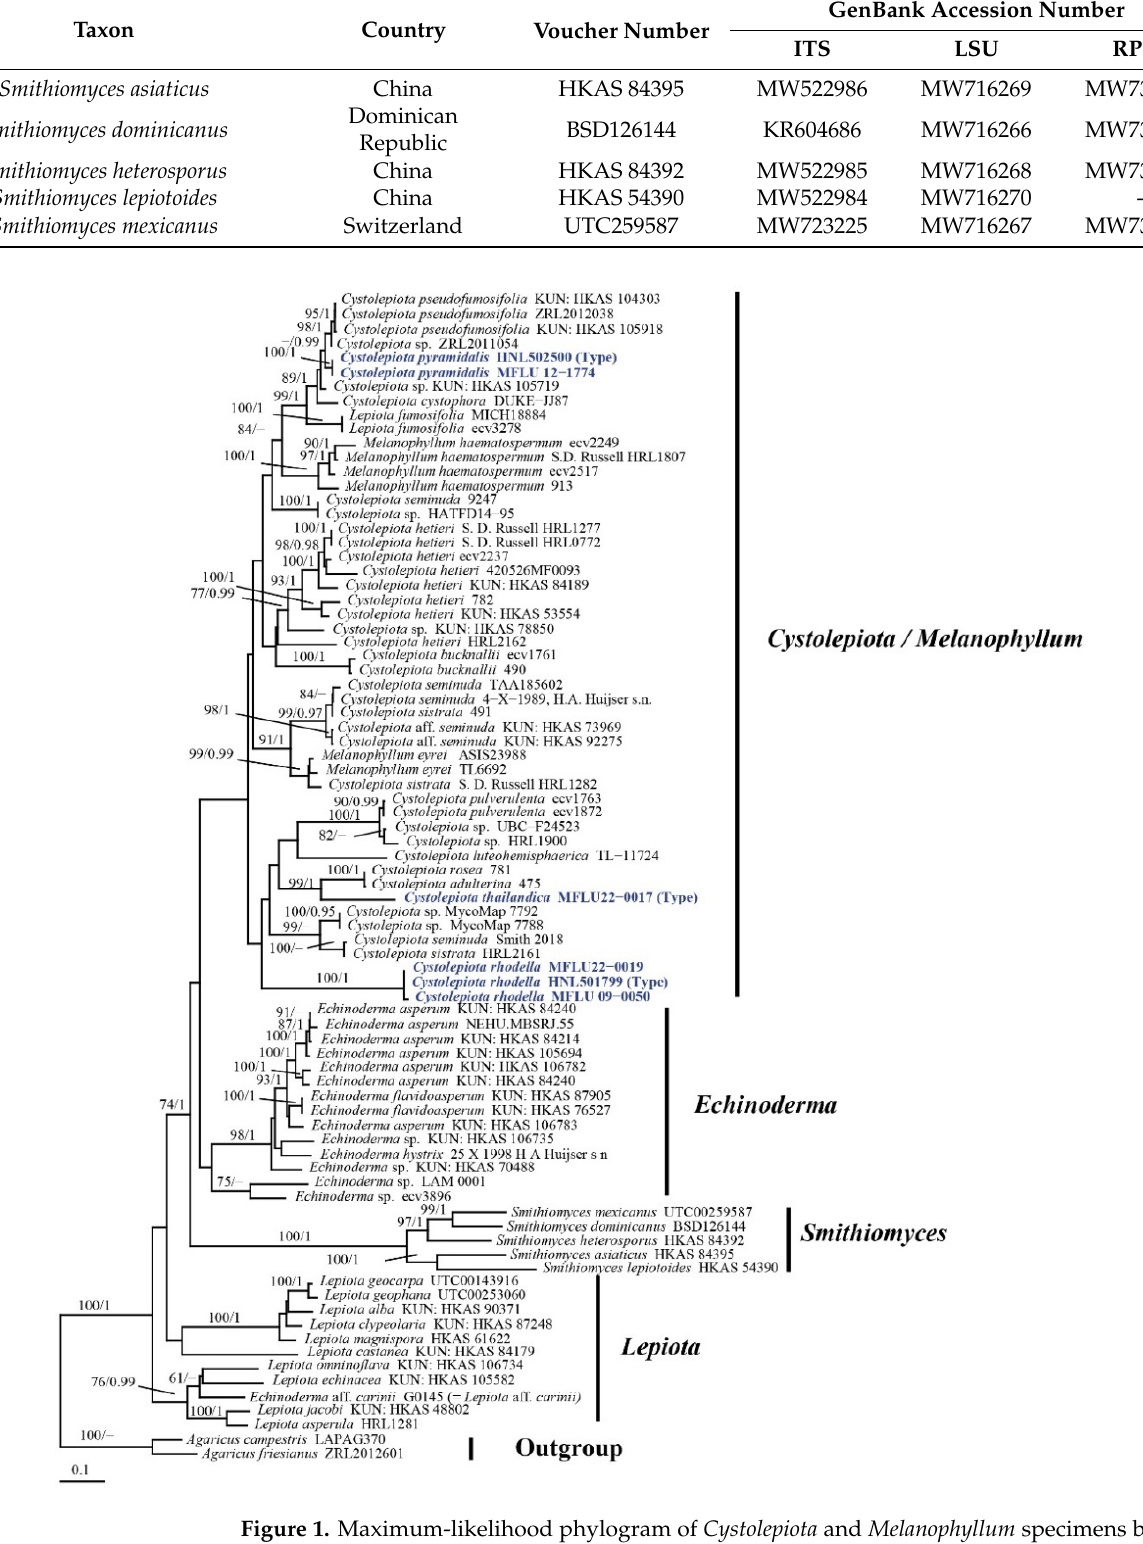
Figure 1. Maximum-likelihood phylogram of Cystolepiota and Melanophyllum specimens based on combined nrITS-LSU and RPB2 sequences. New sequences generated for this study are in blue. Bootstrap values of ML ≥ 60%, and BI ≥ 0.95 are indicated above the branches (ML/BI). Agaricus campestris L. and Agaricus friesianus L.A. Parra, Olariaga & Callac are chosen as outgroup.